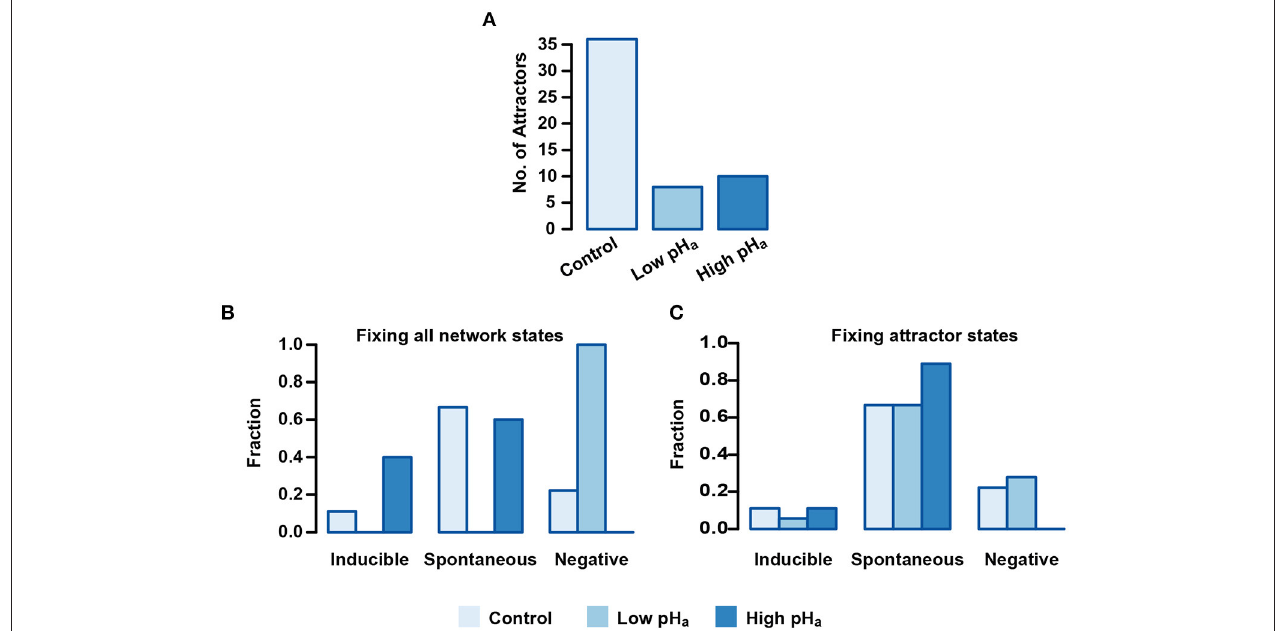
FIGURE 9 | pH a blocking effect on Inducible, Spontaneous, and Negative basins of attraction. (A) Number of total attractors when the pH a node is fixed as acidic (0) or alkaline (1) on the entire state space. (B) Distribution of attractors among functional classes fixing pH a as in (A) . Setting pH a = 0 results in the deletion of Inducible and Spontaneous attractors, whereas fixing pH a = 1 leads to deletion of the Negative class. (C) Attractors distributed among the different functional classes where pH a is fixed only in the attractor states. Fixing pH a = 1 on the sequence of Negative attractors transforms them in Spontaneous